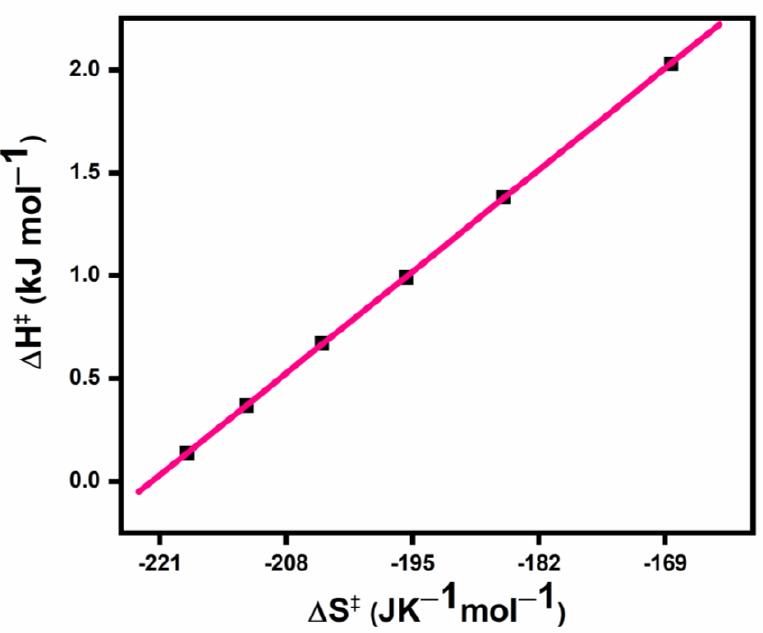
Figure 5. Isokinetic plot of the activation parameters for the reduction of cis- [Co(ip) 2 (C 12 H 25 NH 2 ) 2 ](ClO 4 ) 3 by ion(II) in DPPC medium. [Complex] = 4 × 10 − 4 mol dm − 3 ; [Fe 2+ ] = 0.01 mol dm − 3 ; [μ] = 1.0 mol dm − 3 . ( Entropy and Enthalpy of activation is symbolized ΔS ‡ and ΔH ‡ ).